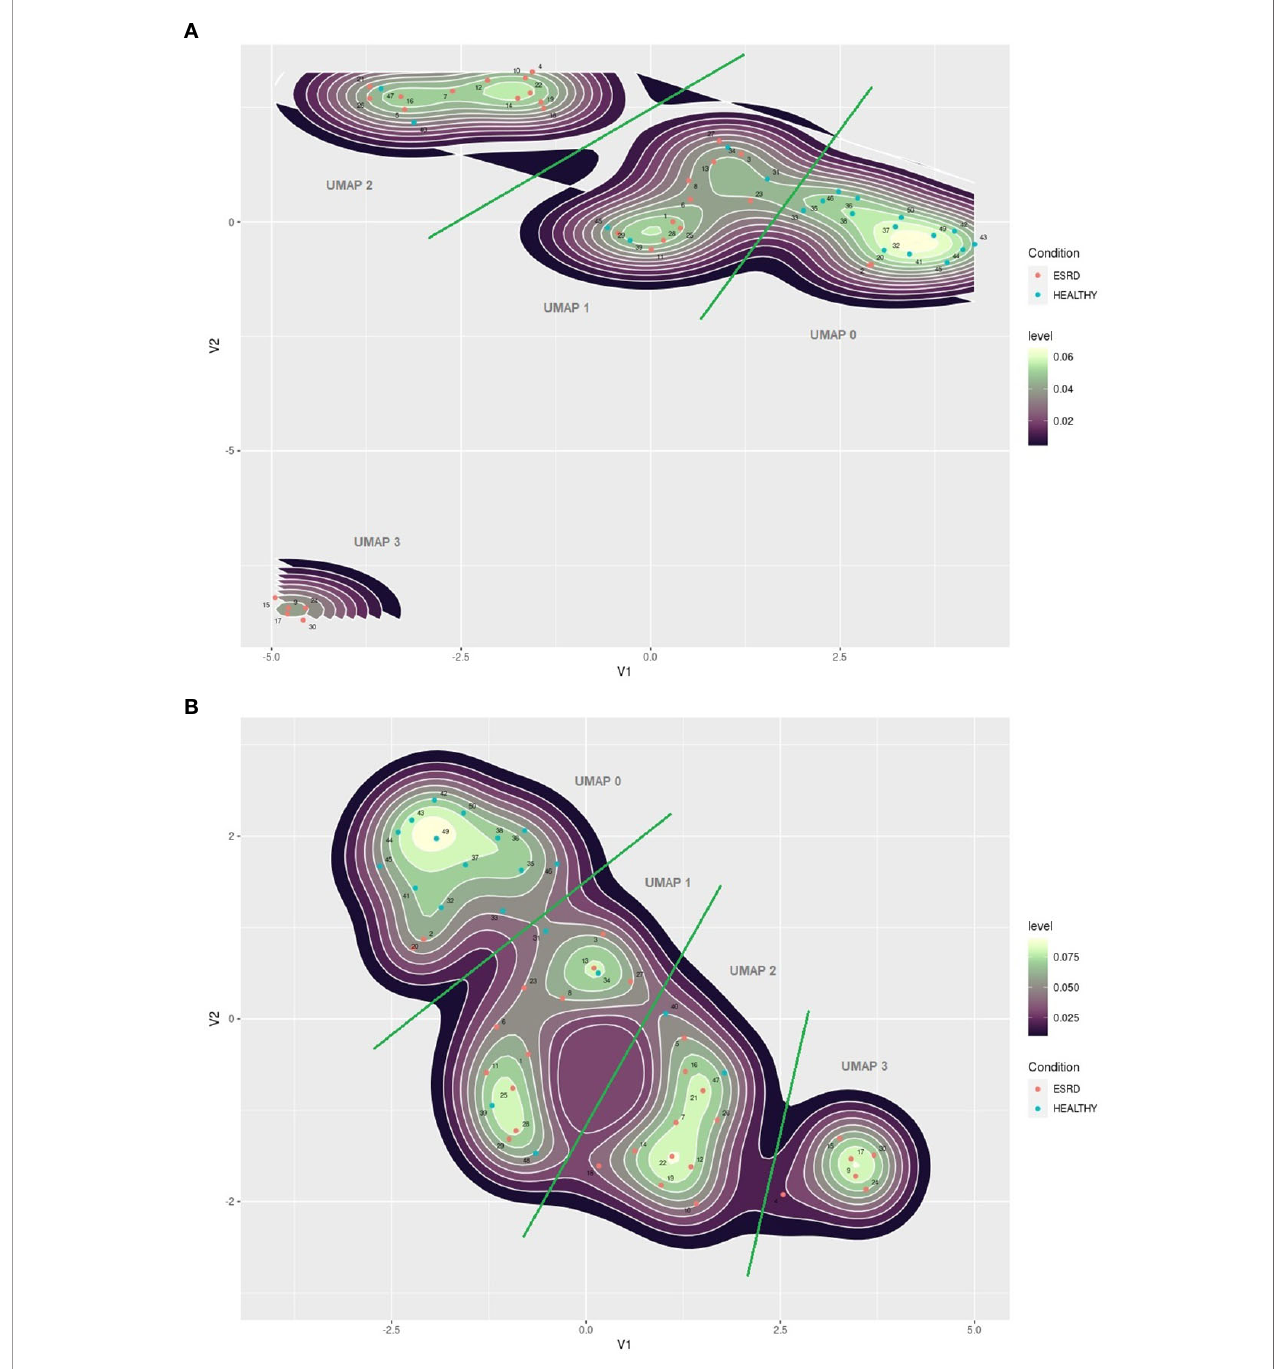
FIGURE 3 | (A) UMAP plot of immune senescence markers of ESRD patients and healthy controls, 2 components, 5 neighbors. (B) UMAP plot of immune senescence markers of ESRD patients and healthy controls, 2 components, 10 neighbors. The red points indicate ESRD patients and the blue points healthy individuals. Numbers indicate patients